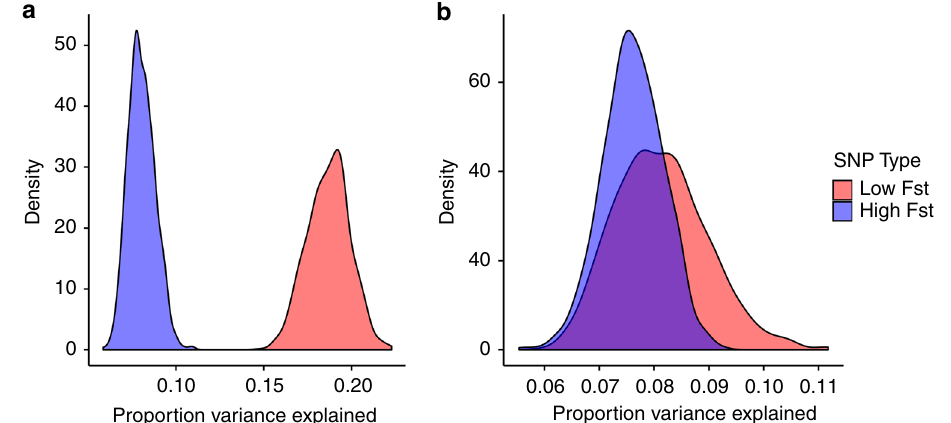
Fig. 4 Empirical distribution of estimated variance components for high and low F ST G × E interaction. Distributions of G × E variance attributable to high and low F ST SNPs for grain yield ( a ) and plant height ( b ) from 1000 replicated model fi ttings. 1248 high F ST SNPs were included, while each model fi tting used a subsample of 1248 low F ST SNPs chosen randomly from the full set of 263,243 low F ST SNPs. Proportion variance explained represents non- environmental model variance, i.e., was calculated using only genotype, G × E for high and low F ST SNPs, and